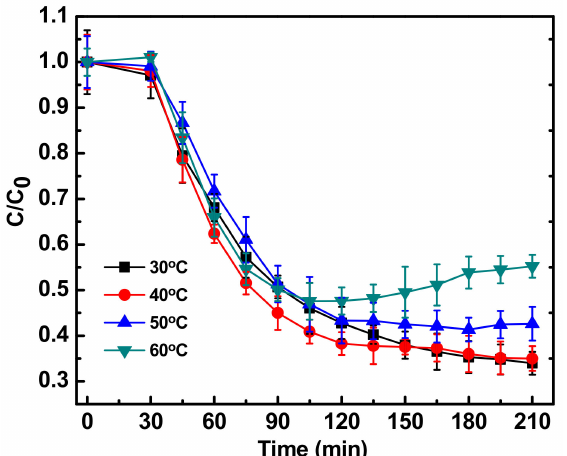
Figure 5. Photocatalytic degradation of antibiotic ciprofloxacin (10 mg/L) in water in the presence of Fe-ZnO nanoparticles (150 mg/L) irradiated with sunlight intensity of 80,000 ± 3000 lux and pH 9 with different reaction temperature. C 0 represents initial concentration of ciprofloxacin and C represents concentration of ciprofloxacin at a particular time point. C/C 0 denotes the time dependent change in ciprofloxacin concentration with respect to initial